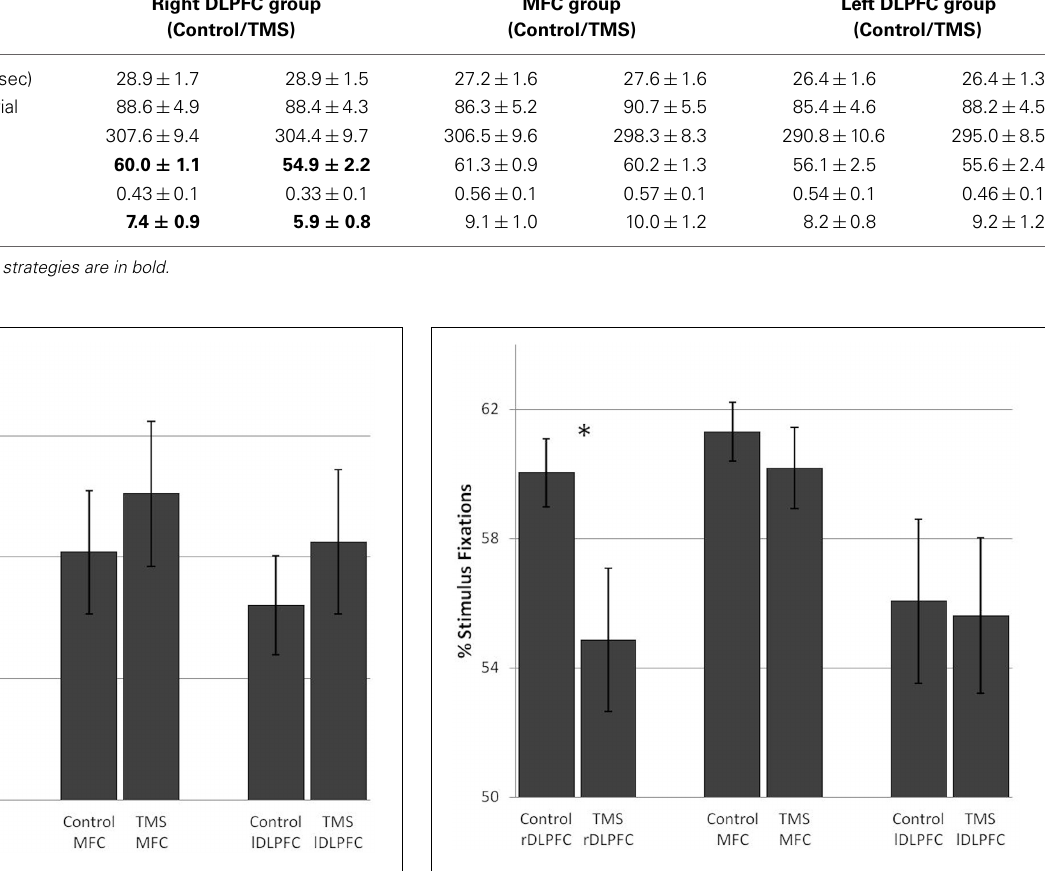
FIGURE 3 | TMS effects on the percentage of stimulus fixations in the number search task. A significant difference in stimulus fixations between the control and TMS condition was found after stimulation over the right dorsolateralprefrontalcortex.Errorbarsindicatestandarderrors(SE). ∗